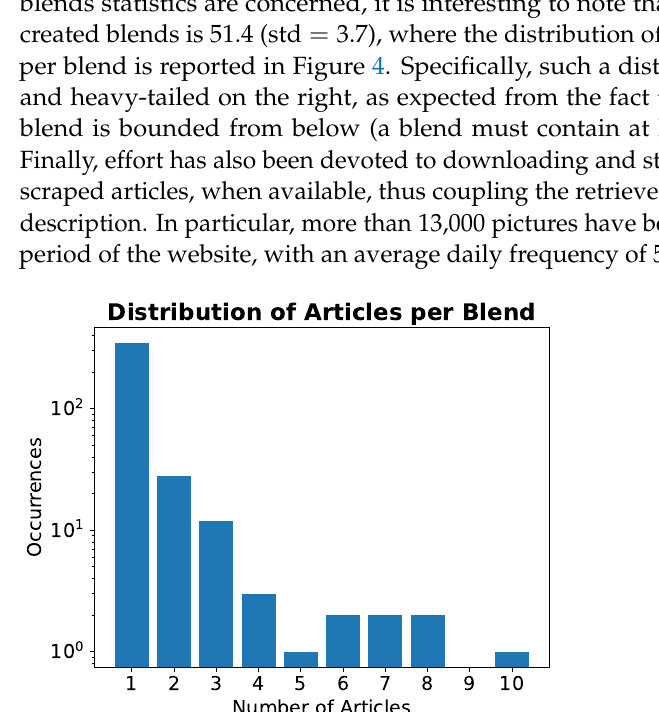
Figure 4. Distribution of the number of articles per blend in logarithmic scale.